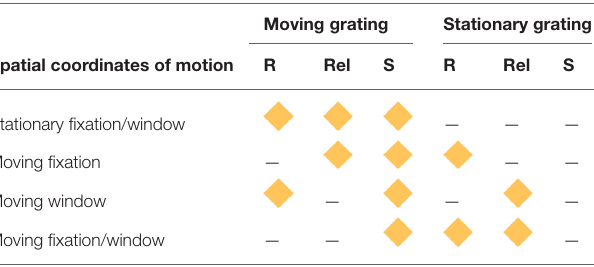
TABLE 1 | Three types of motion observed for each experimental